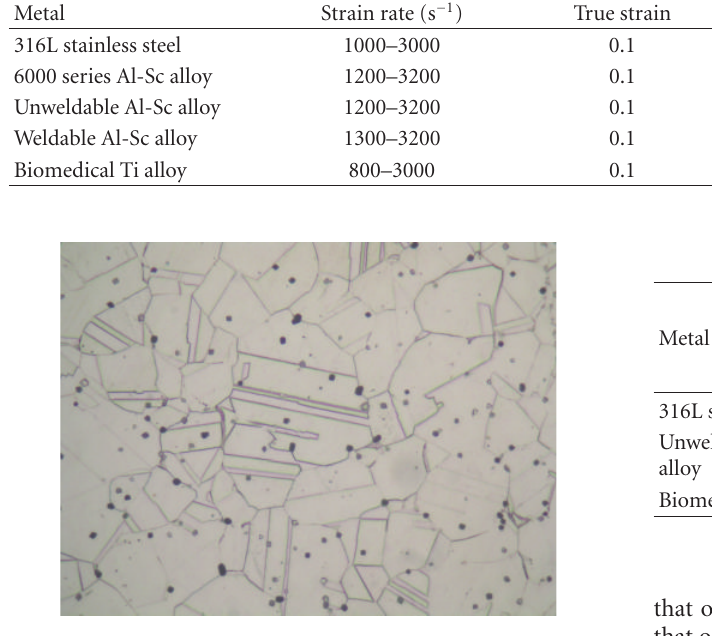
Figure 9: Optical micrograph of undeformed 316L stainless steel specimen.